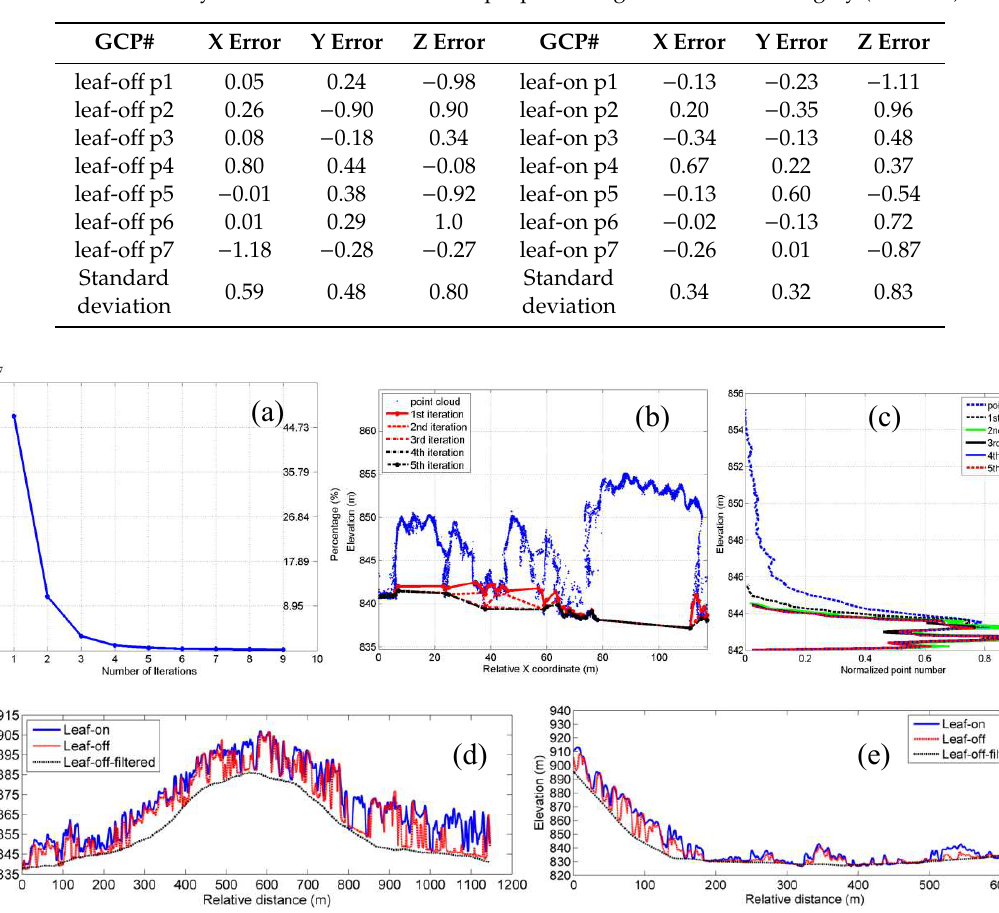
Figure 4. Elevation of ground surfaces extracted from the point cloud of UAV stereo imagery of leaf-off filtered by the method of iterative median filter (IMF). ( a ) The number and percentage of point removed at each iteration; ( b ) the results of each iteration along a vertical profile; ( c ) the results of each iteration over a 30 m × 30 m plot; ( d ) profiles along the white dash line in Figure 3c with an approximate length of 1150 m; ( e ) the profiles along the yellow solid line in Figure 3c with an approximate length of 600 m.